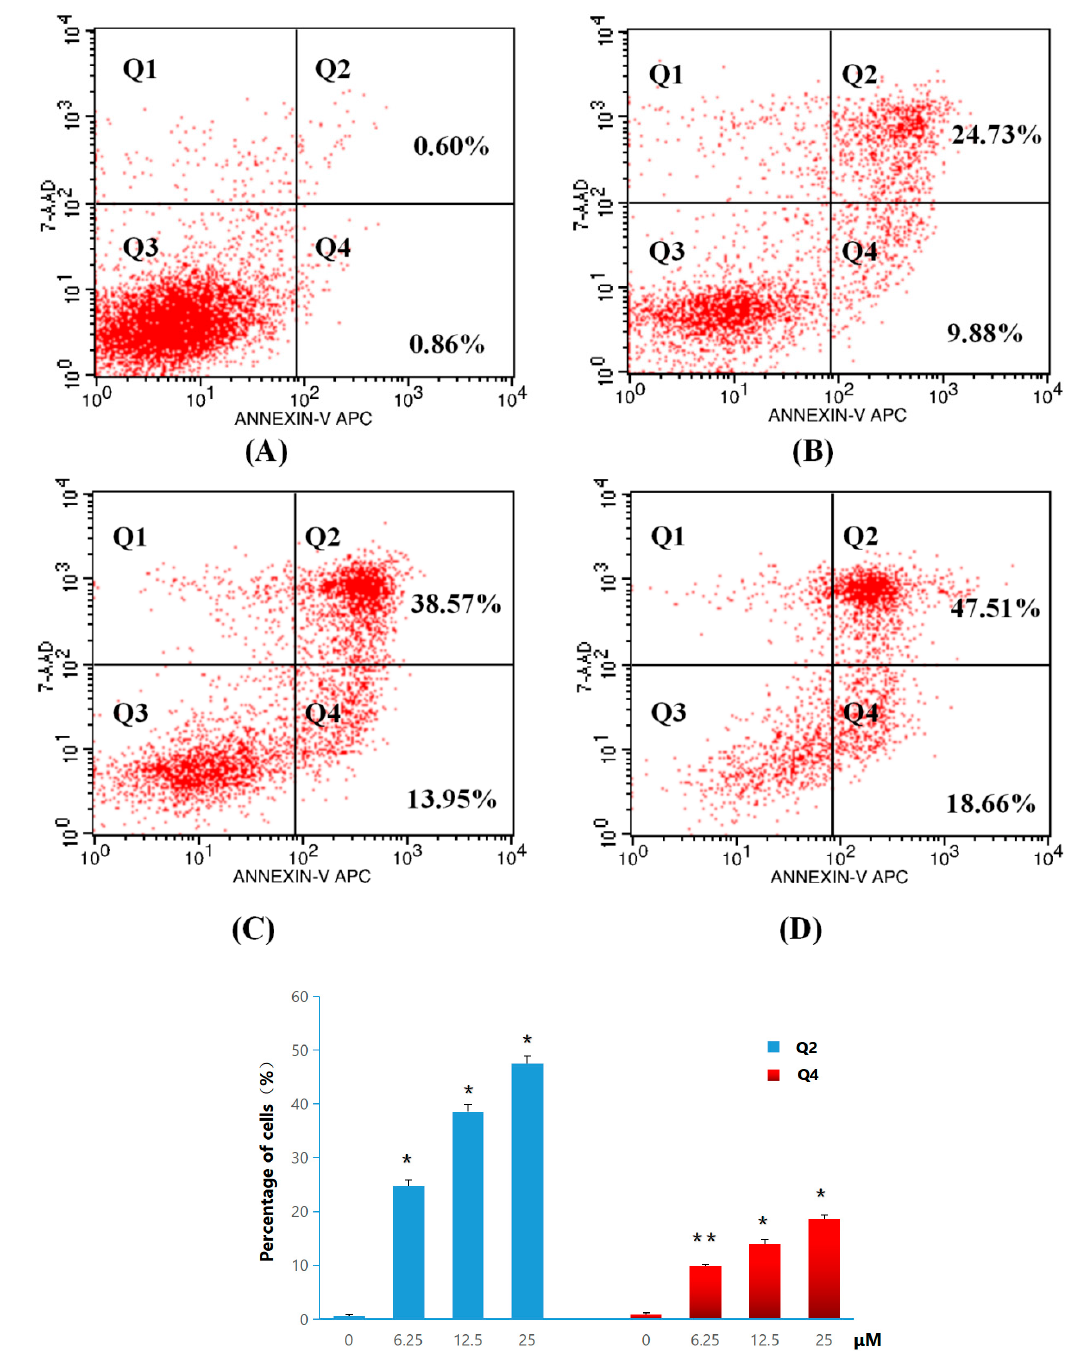
Figure 9 . Apoptosis ratio detection of compound 2i for 48 h by Annexin V/PI assay. ( A ) Not treated with compound 2i (control); ( B ) treated with compound 2i at 6.25 μ M; ( C ) treated with compound 2i at 12.50 μ M for and ( D ) treated with compound 2i at 25 μ M ( E ) The percentage of quadrants Q2 and Q4 are shown as mean ± SD. Data shown in the figure represent three independent experiments (* p < 0.05, ** p < 0.01).